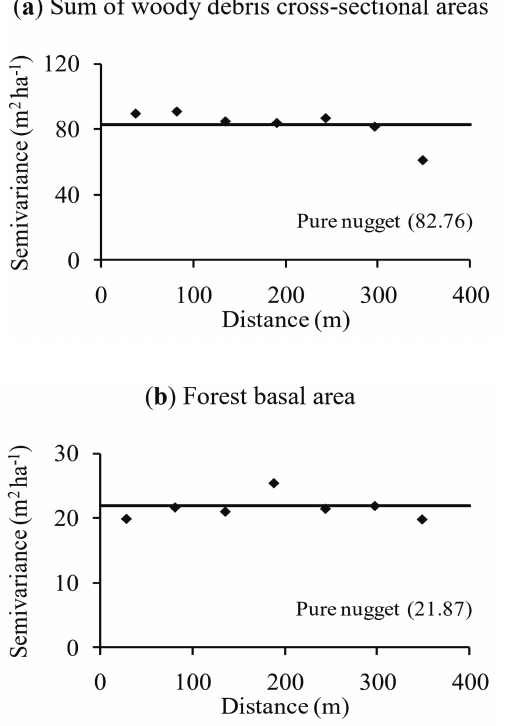
Figure 3 - Semivariograms fitted to the sum of woody debris cross-sectional areas ( a ) and forest basal area ( b ) in an urban mixed tropical forest.